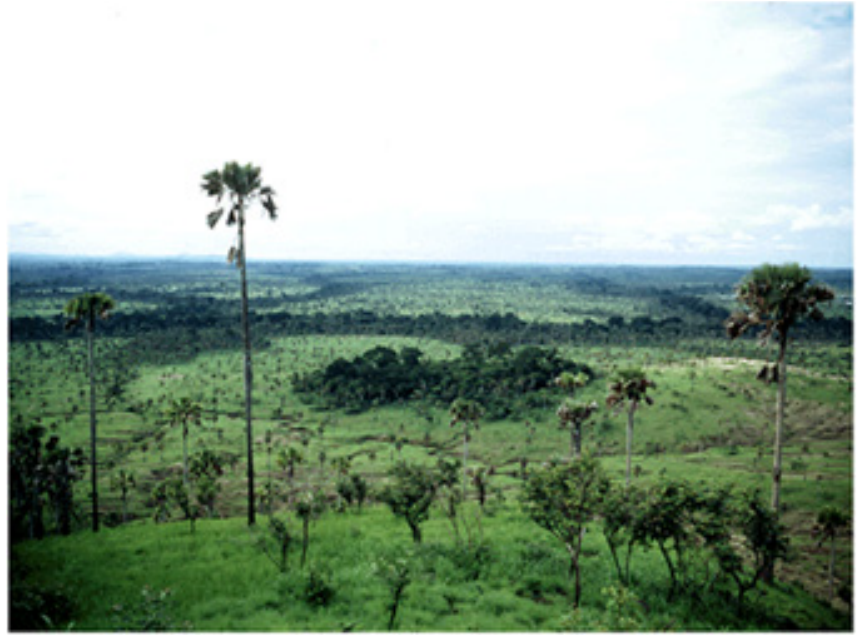
Fig. 2. General view of Lamto, Ivory Coast. In the foreground humid savannah with Borassus L. palms. In the background a network of gallery forest along tributary streams of the R.